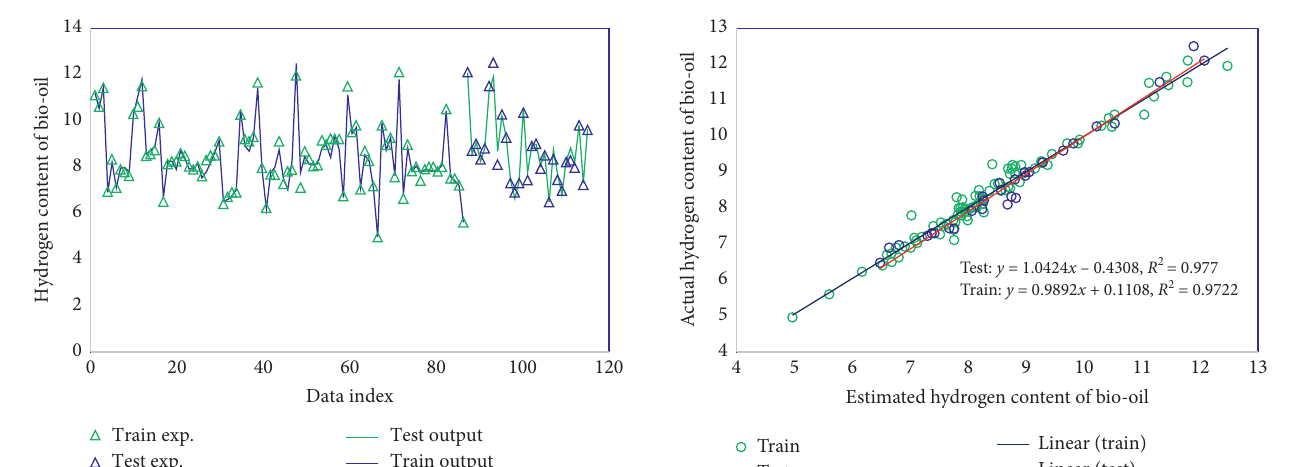
outputTest output Train